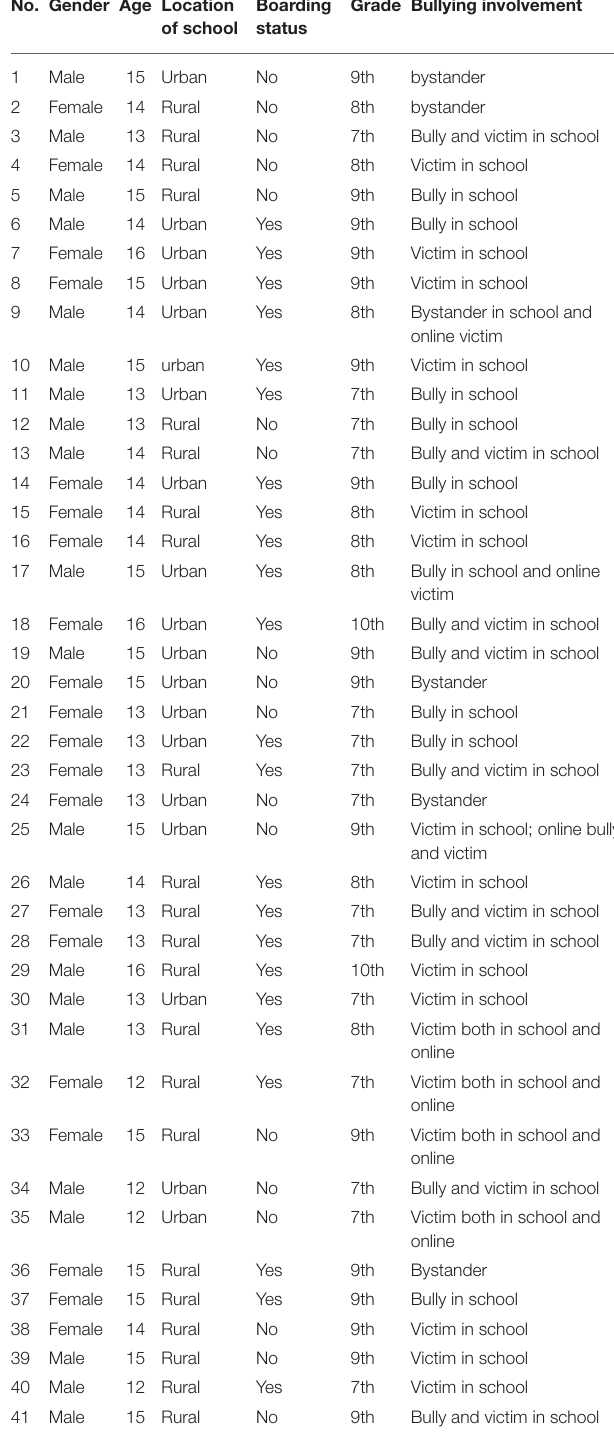
TABLE 1 | Sociodemographic information of